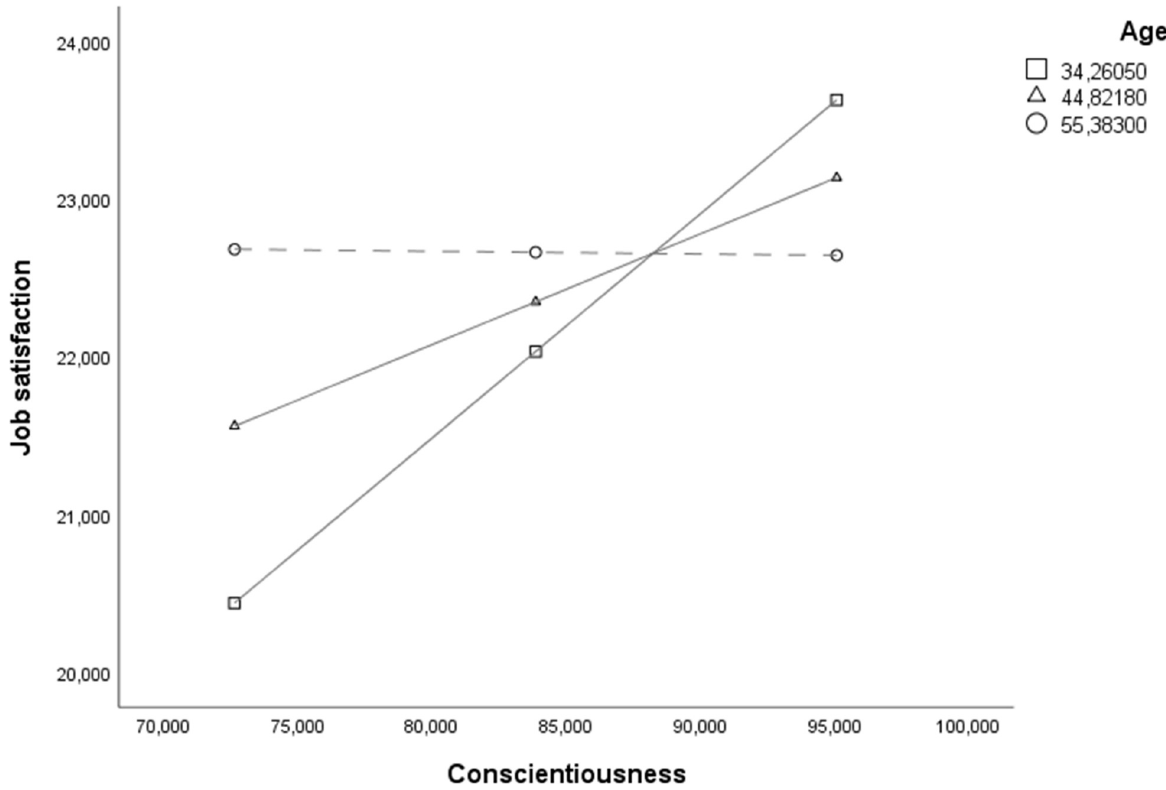
Fig 2. Moderation chart. Graphical representation of the moderation effect.